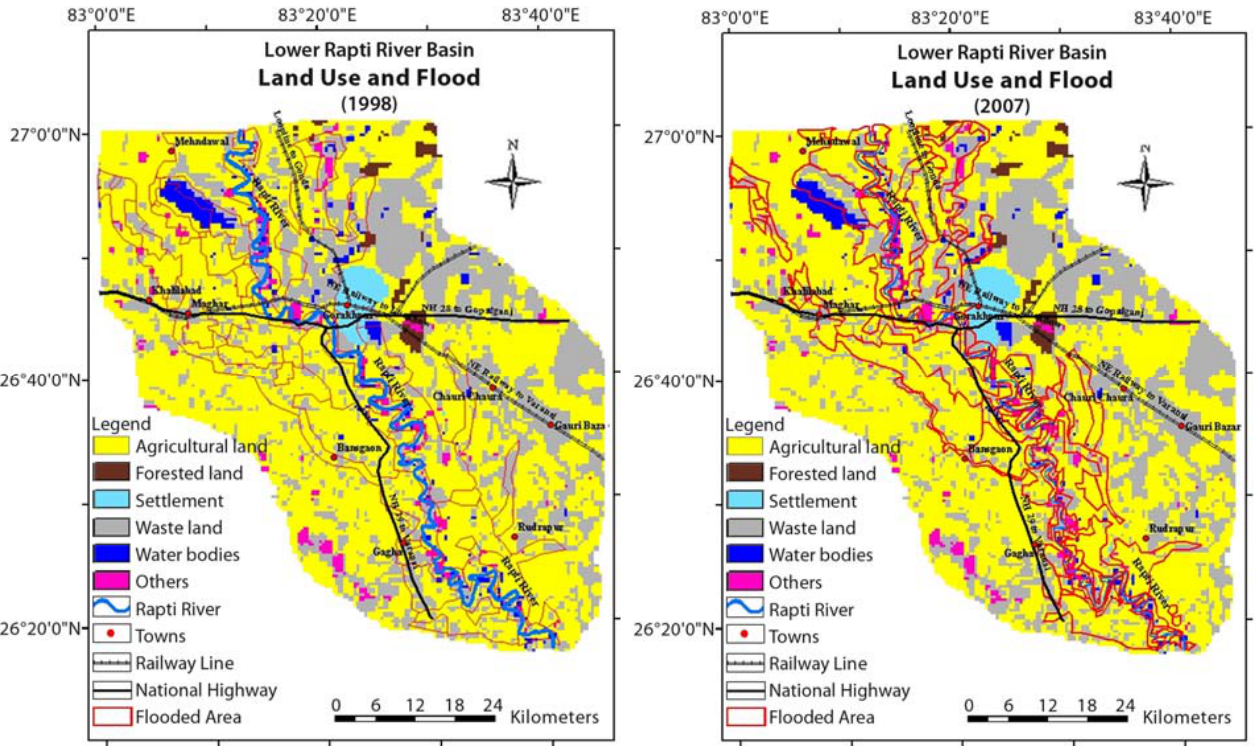
Fig. 3. Spatial impact of flood events at Gorakhpur, India.